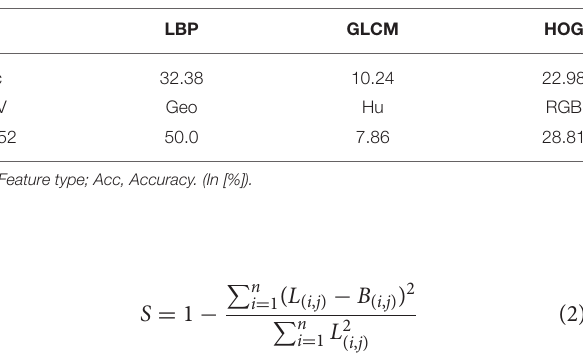
TABLE 9 | Different results obtained by applying different features in the EMDS-6 classification experiments using